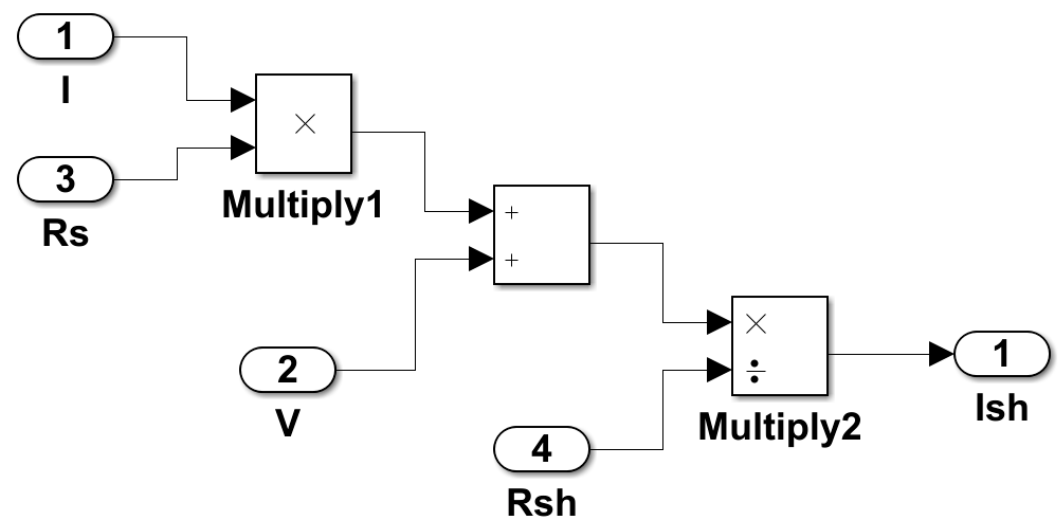
Figure 4. The output current diagram.